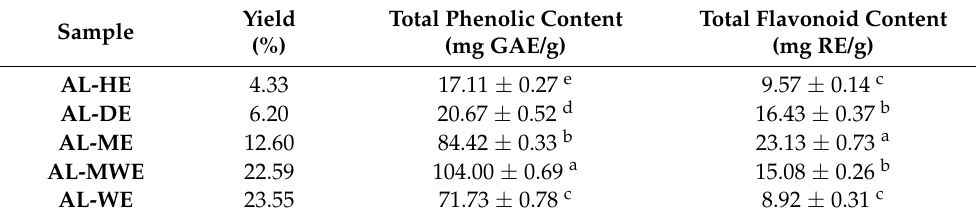
Table 1. Extraction yields, total phenolic, and flavonoid content of Artemisia campestris subsp. lednicensis